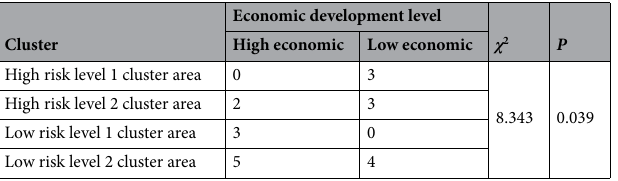
Table 5. Correlation Analysis of Annual GDP and Tuberculosis Incidence Clusters in Provinces and Cities from 2008 to